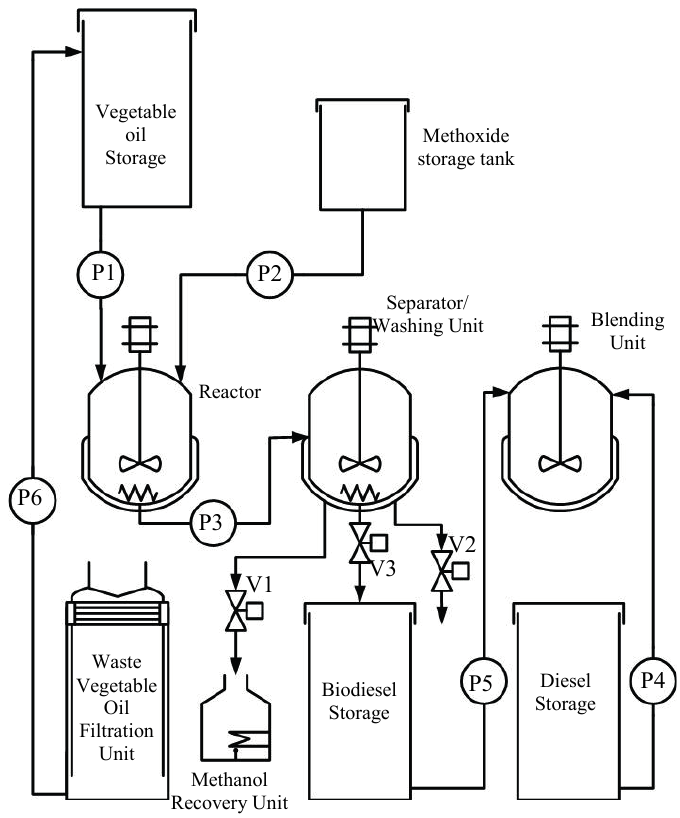
Fig. 3. Schematic diagram of the